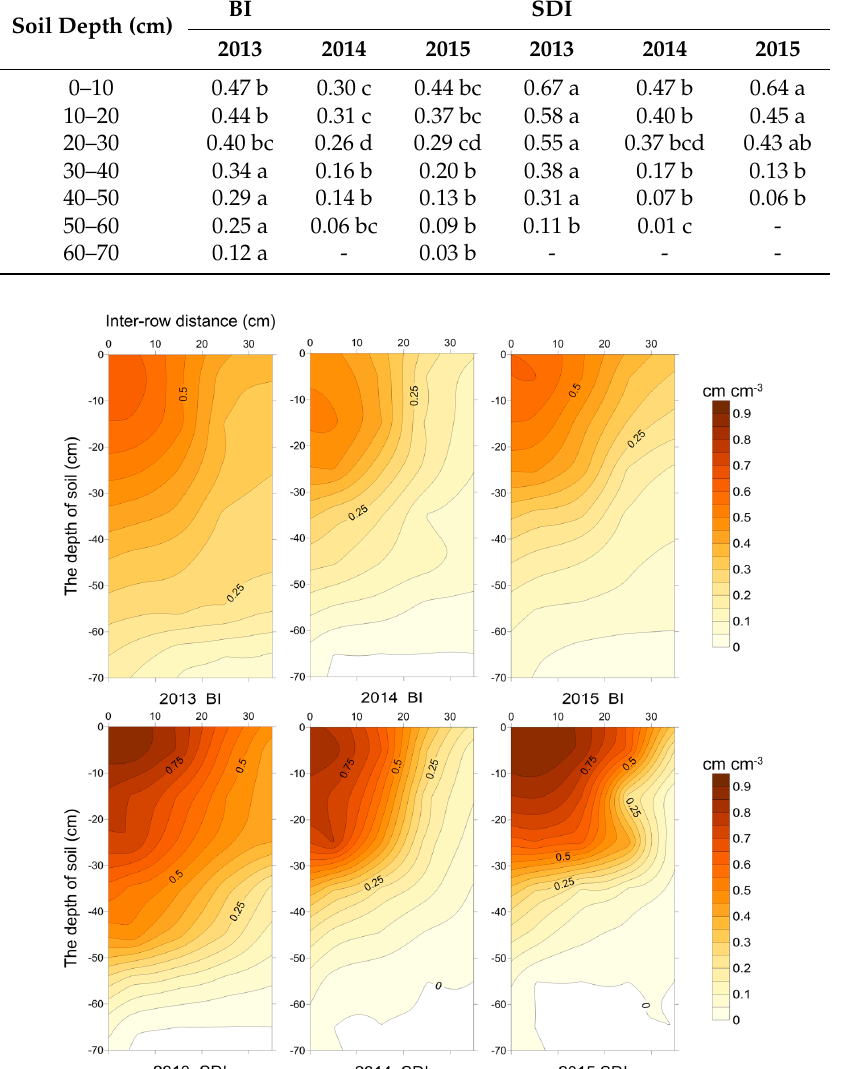
Table 5. The RLD (cm cm − 3 ) measured at different soil depths in 2013, 2014 and 2015. Abbreviations: BI, border irrigation; SDI, surface drip irrigation; and RLD, root length density. Letters indicate statistical significance at p = 0.05 level within the same row, and the values are the means of three replicates.